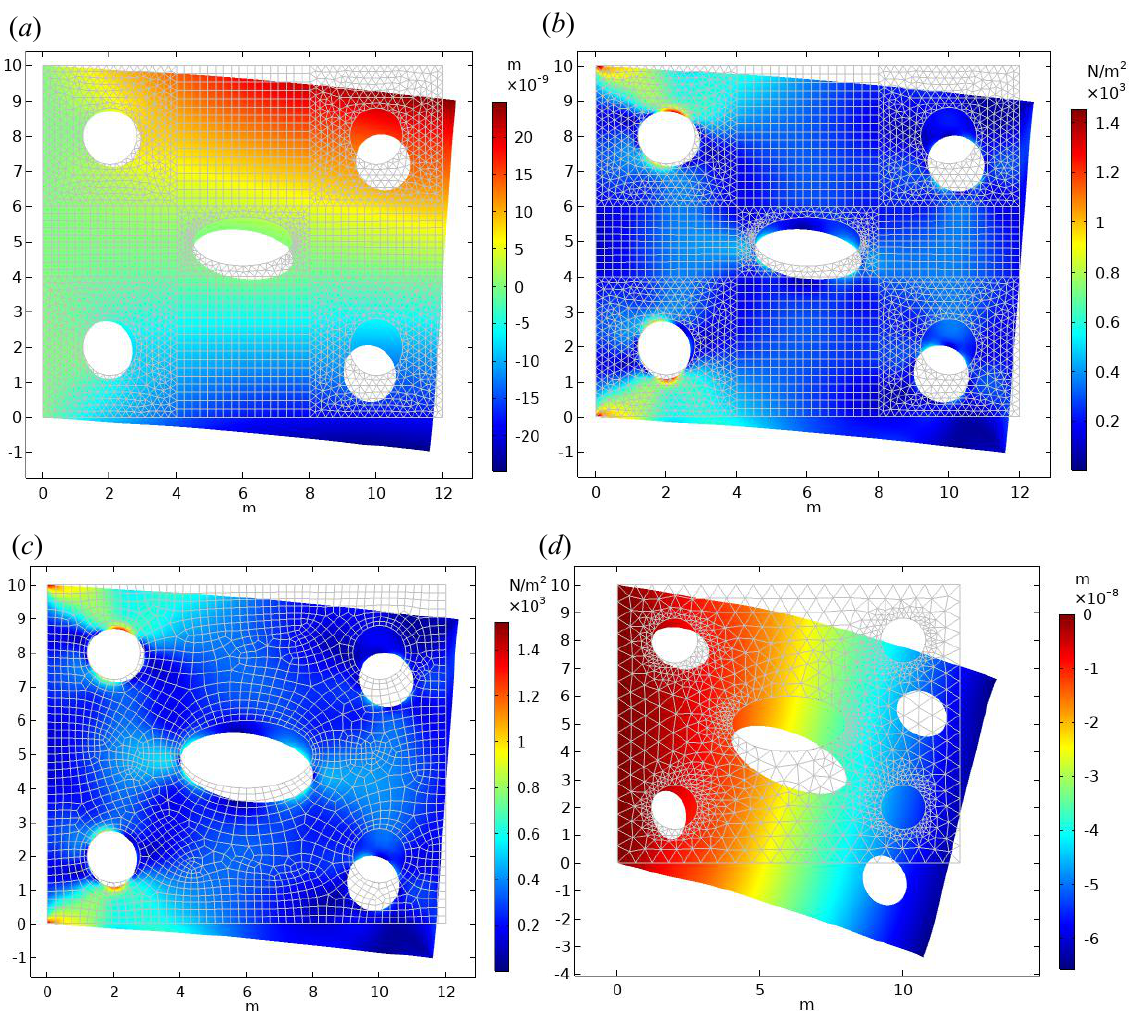
Figure 3. Numerical results of hybrid finite-element 2D thin-plate deformation. ( a ) Numerical solution of the hybrid finite-element displacement component U . ( b ) Numerical solution of Von Mises stress. ( c ) Von Mises solution of Q4 element adaptive FEM contour diagram of the numerical solution of stress. ( d ) Schematic diagram of the displacement component V of the CST element adaptive FEM